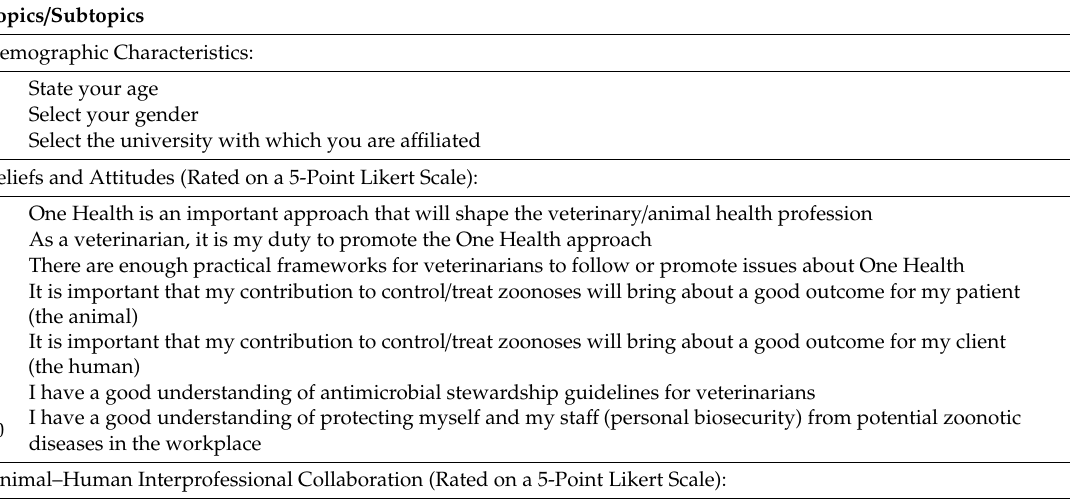
Table 1. Survey questions and